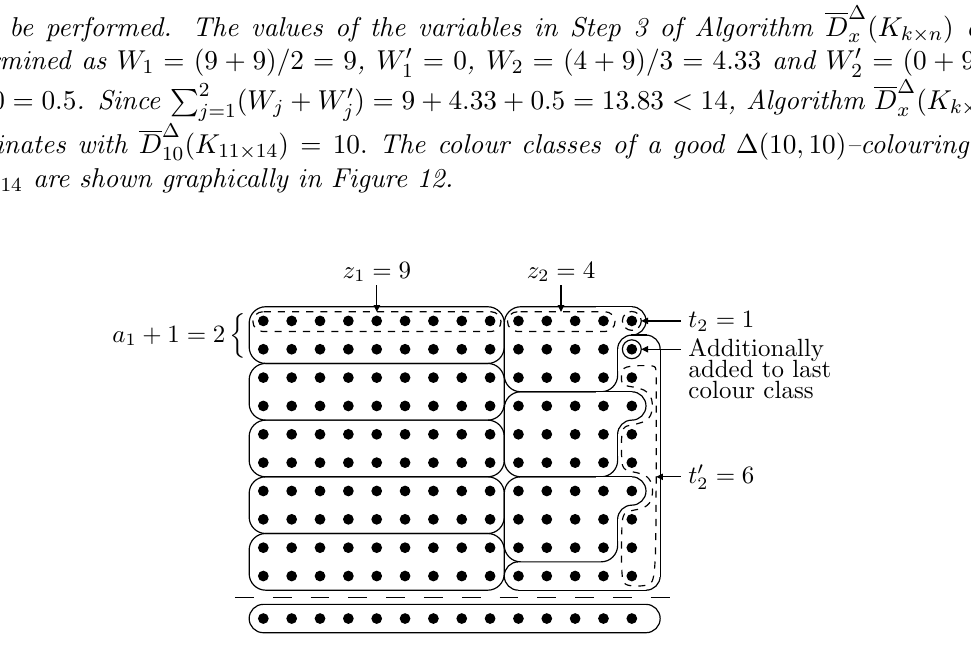
A graphical representation of the discretisation approach achieved in Algorithm D ∆ ( K k × n ) for the graph K 11 × 14 considered in Examples 4(b) and 5. The corresponding ideal x ∆(9 , 10) –colouring was represented graphically in Figure